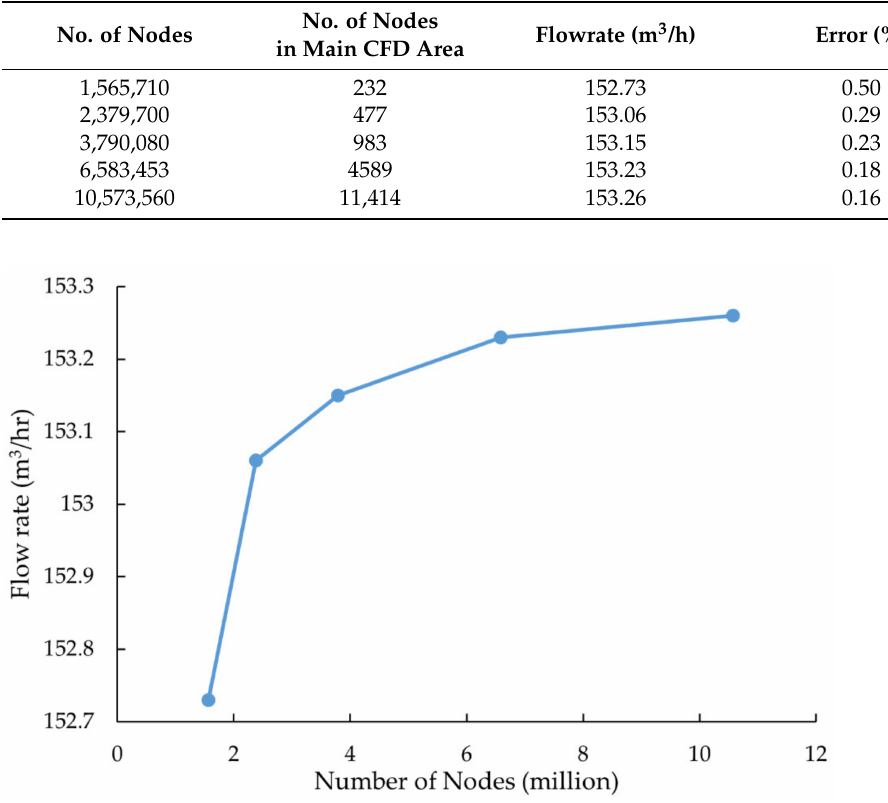
Figure 7. Mesh sensitivity study